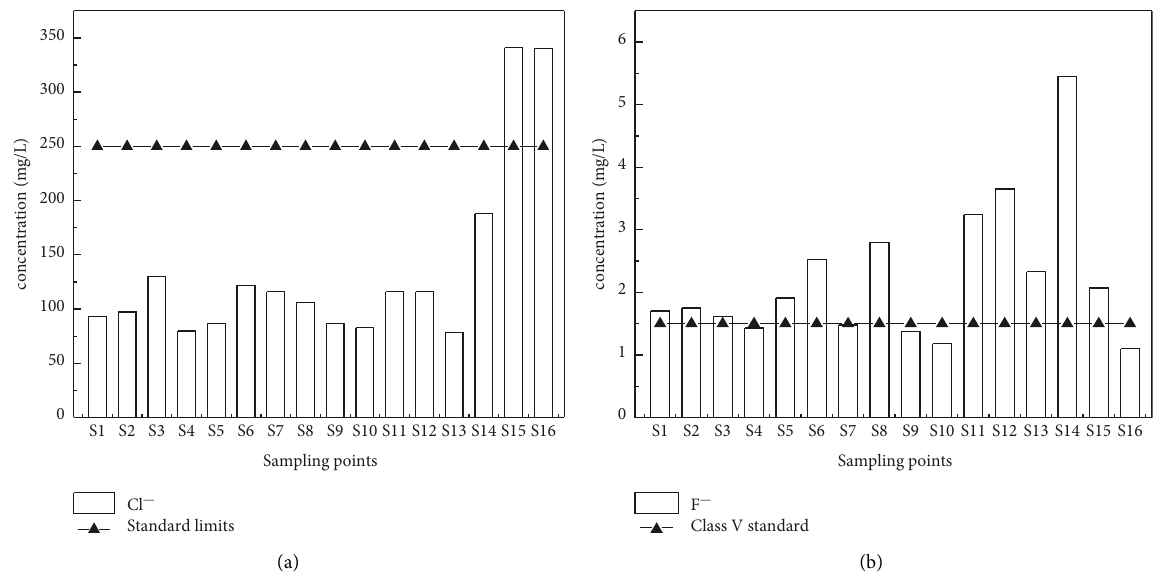
Figure 5: The content of Cl − (a) and F − (b) at each sampling point in the Huainan coal mining subsidence water bodies. (The standard limits of Cl − in the figure refer to the standard limits of supplementary items of centralized surface water sources for drinking